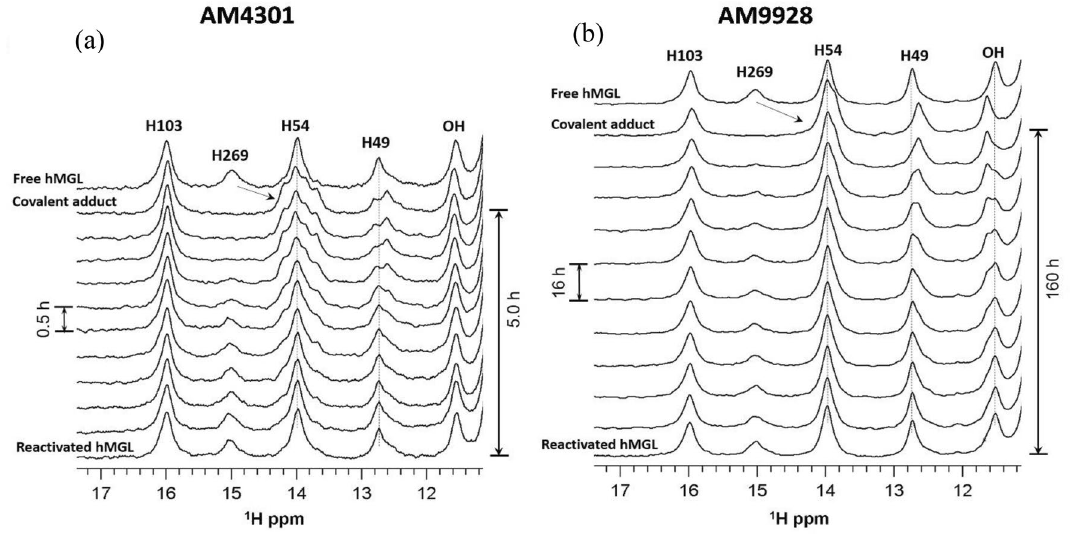
Figure 1. Downfield 1 H NMR spectra of hMAGL. Formation of covalent adducts with the MAGL